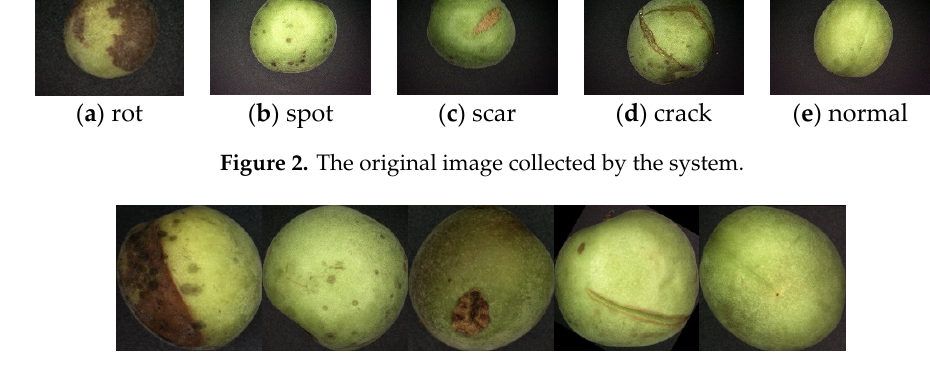
Figure 3. Preprocessed image.